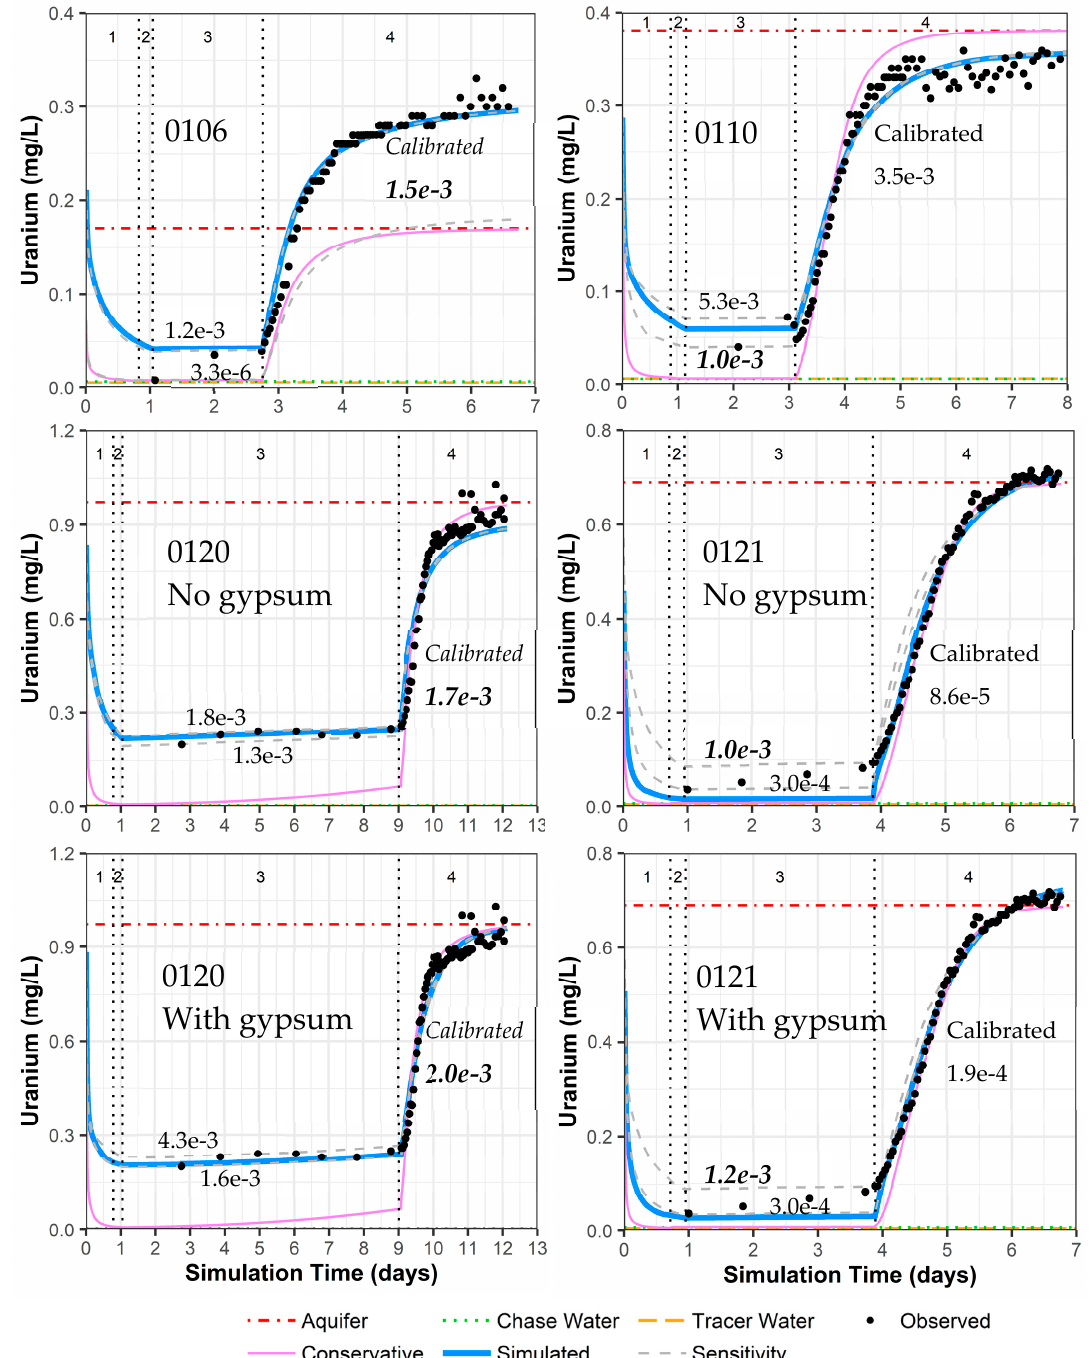
Figure 9. Model fit for uranium in all PPT wells, with and without gypsum addition for wells 0120 and 0121. Phases are: (1) traced river water injection, (2) untraced river water injection (chase), (3) drift phase, and (4) pumping phase. Posted values are the GC_s uranium sorption parameter values (moles/kg-water) for the upper and lower sensitivity testing (gray dashed curve) and the calibrated value from Table 4 (solid blue curve). GC_s values in bold italics indicate the authors’ picks for the best final values.